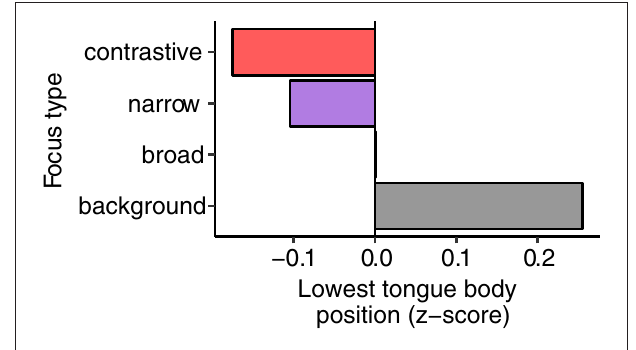
FIGURE 6 | Mean values of lowest tongue positions ( z